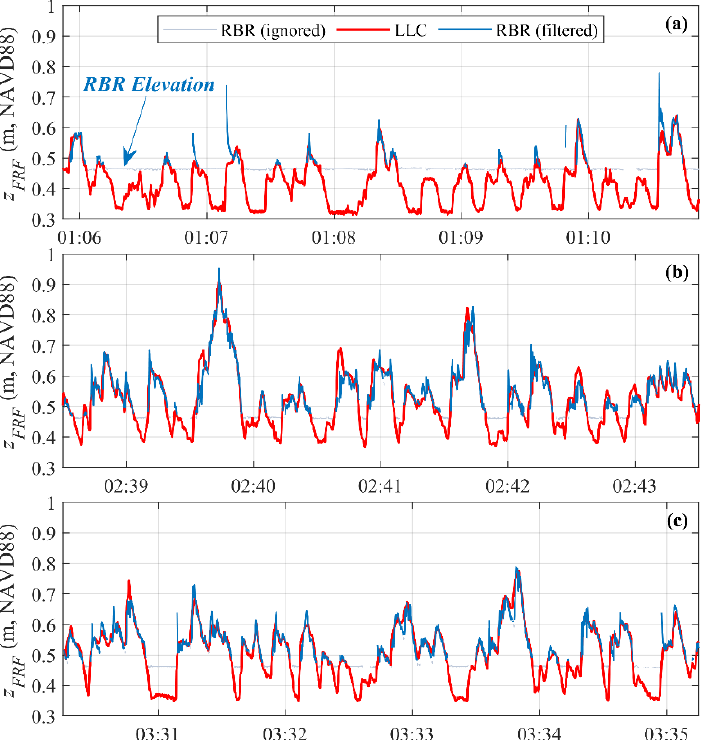
Figure 13. Three 5-minute segments of beach and free-surface elevations derived from the LLC Li-DAR and RBR ( a ) during mid-rising tide, ( b ) at high tide, and ( c ) during mid-falling tide. Times in UTC. Bed level changes (